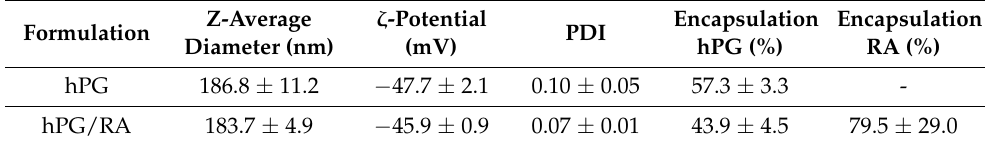
Table 1. Properties of liposomes, means ± SD.